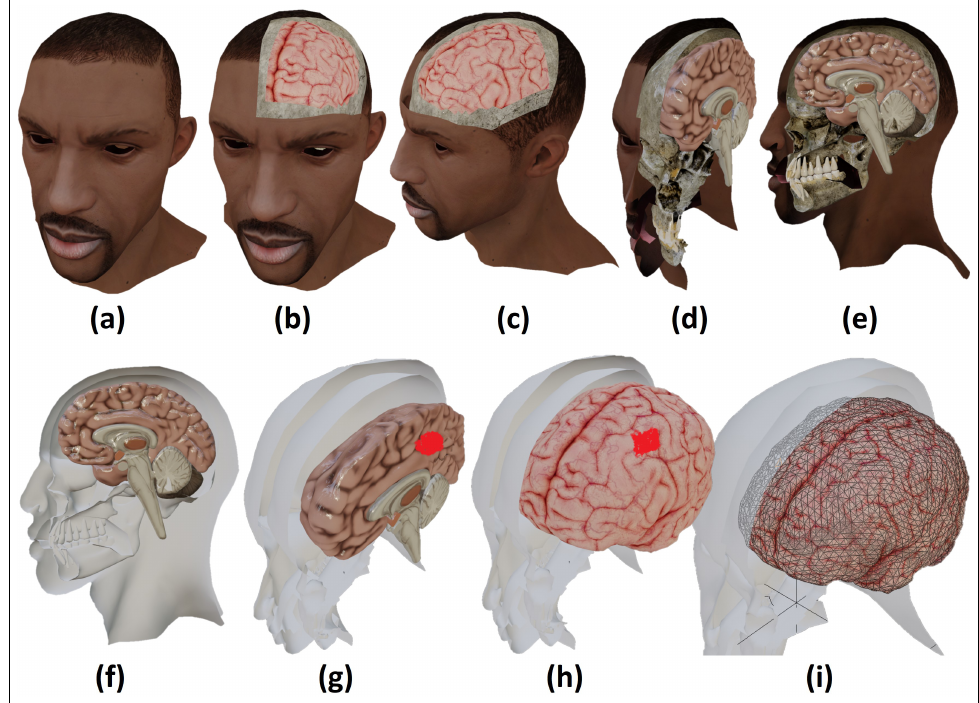
Figure 1. ( a ) 3D model of a human head; ( b ) cut in the skull and scalp in the upper-frontal left region to show the frontal and parietal brain lobes; ( c ) rotation of the cut in ( b ); ( d ) transversal cut in ( c ) to show the inner region of the brain. The skull and scalp are shown as interfaces; ( e ) profile of ( d ). ( f ) The same as ( e ), contrasting the skull and scalp in white; ( g ) rotation of ( f ) showing in red a region in the inner brain zone representing an anomaly; ( h ) the same as ( g ), showing the whole brain. We indicate in red a possible anomaly in the brain surface. ( i ) mesh of the brain, similar to a 3D mesh for applying certain types of numerical